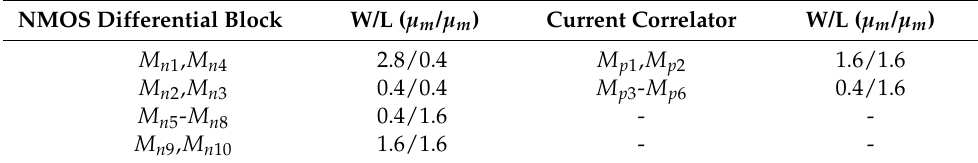
Table 1. MOS Transistor Dimensions (Figure 1).